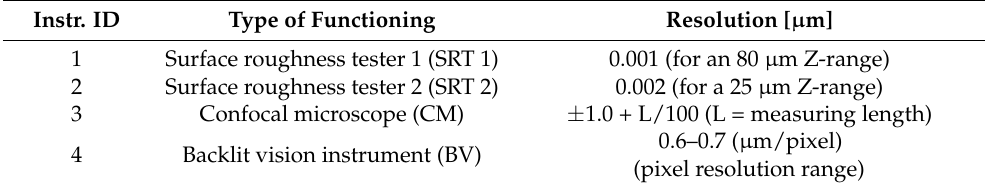
Table 2. Summary of instruments.